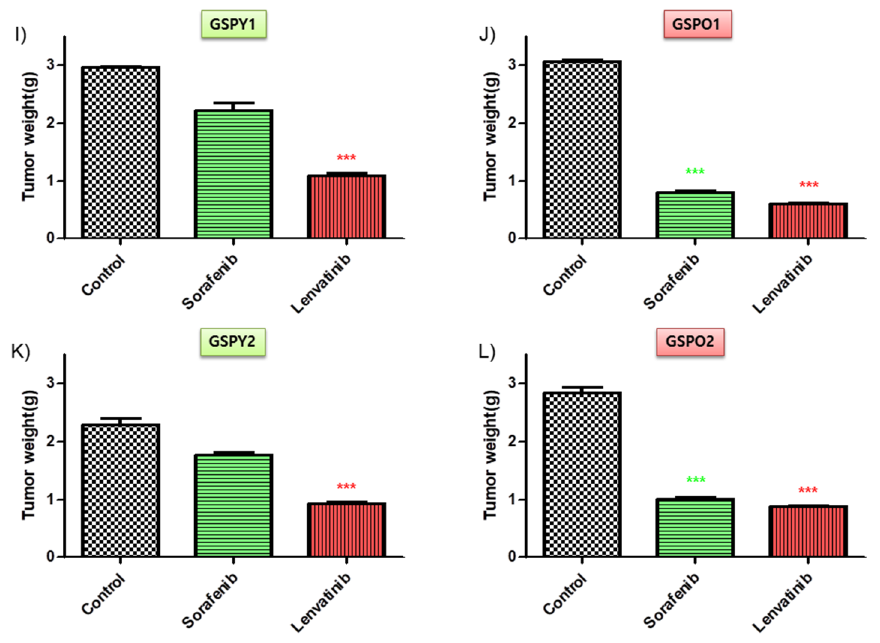
Figure 4. Tumor-selective anti-cancer effects of lenvatinib or sorafenib in patient-derived papillary thyroid cancer cell xenografts in vivo. Athymic nude mice with established tumors were treated with the indicated inhibitors. Data represent the mean tumor volumes. Inhibition of tumor progression by therapy with lenvatinib or sorafenib in mice grafted with patient-derived papillary thyroid cancer cell: ( A , E , I ) GSPY1; ( B , F , J ) GSPO1; ( C , G , K ) GSPY2; ( D , H , L ) GSPO2 ( n = 10 mice/group). ( A – D ) Change in tumor volume. ( E – H ) The compounds had no significant effect on mouse body weight. ( I – L ) Weight of the dissected tumors. * p < 0.05, ** p < 0.01, and *** p < 0.005 compared with the control.